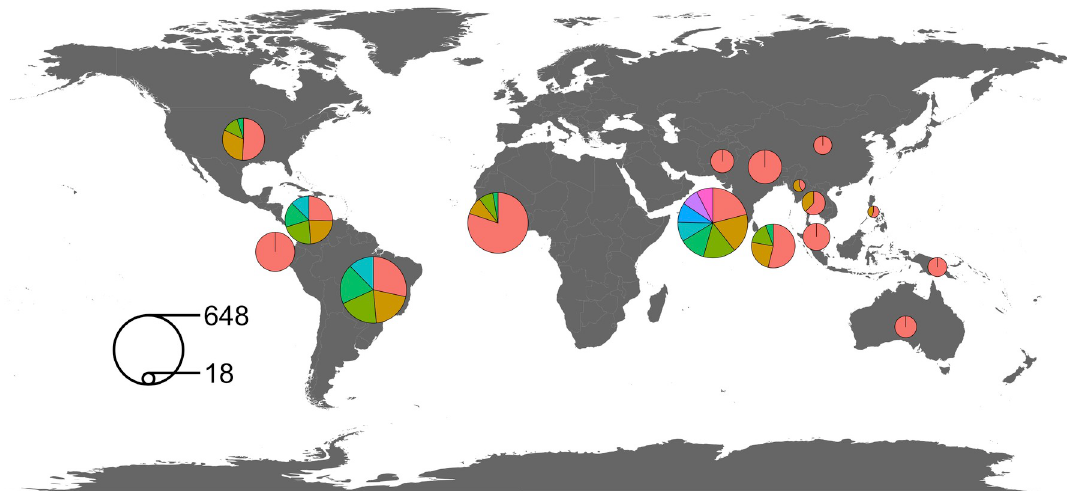
Fig 2. Total number of randomised controlled trial participants by country. The area of each circle is proportionate to the total number of trial participants randomised per country in studies published between 1946 and 2020. The area of the segments of each circle are proportionate to the sample size of individual RCTs (e.g., there has been one large trial and three small trials conducted in Nigeria). Each circle overlies the country that it refers to. Where circles would overlap they have been moved, and the edge of the circle touches the corresponding country. The key demonstrates the samples size that corresponds to the surface area of two example circles. World map sourced from the Natural Earth project (1:50m resolution version)